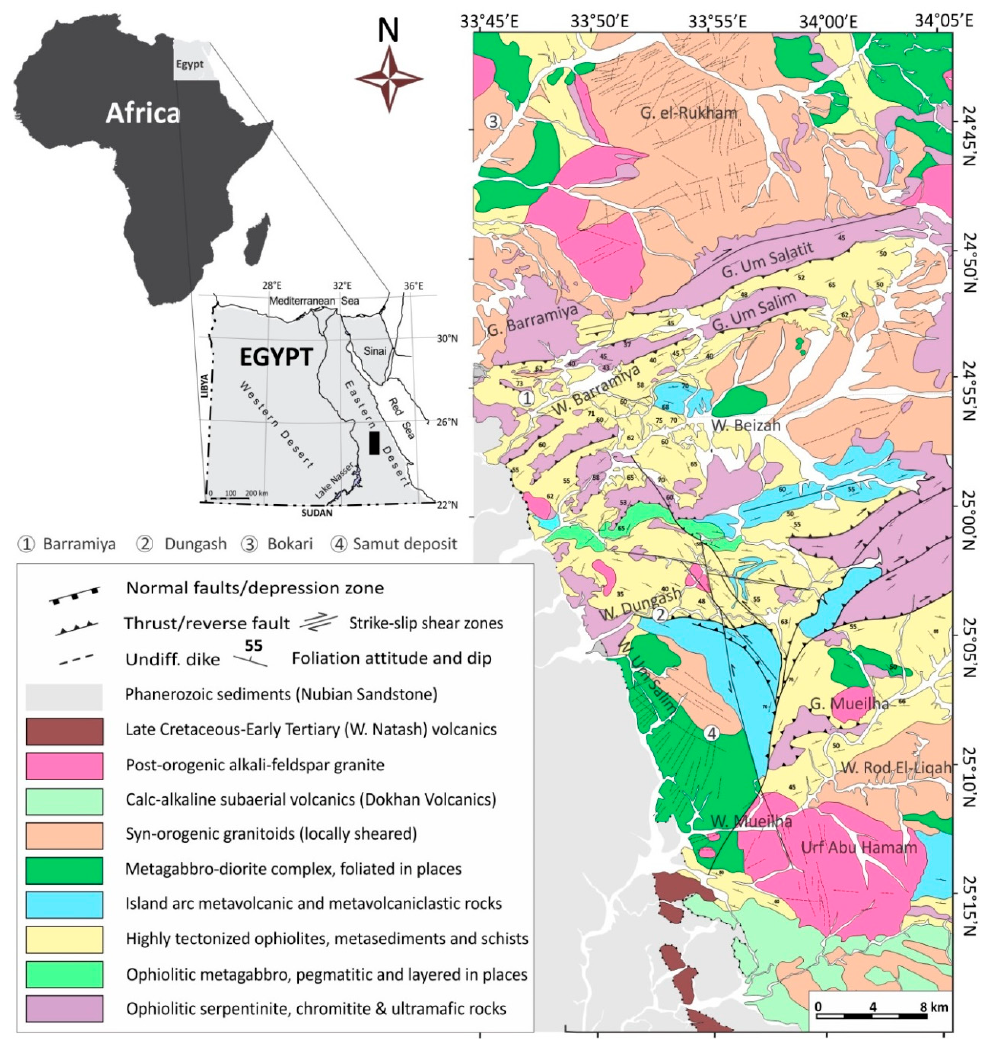
Figure 1. Simplified geological map of the Barramiya–Mueilha sector in the western part of the Central Eastern Desert of Egypt. Compiled from [35,36,44–47] and modifications based on new field verifications. Insets show the location of Egypt in Africa and the study area in Egypt.